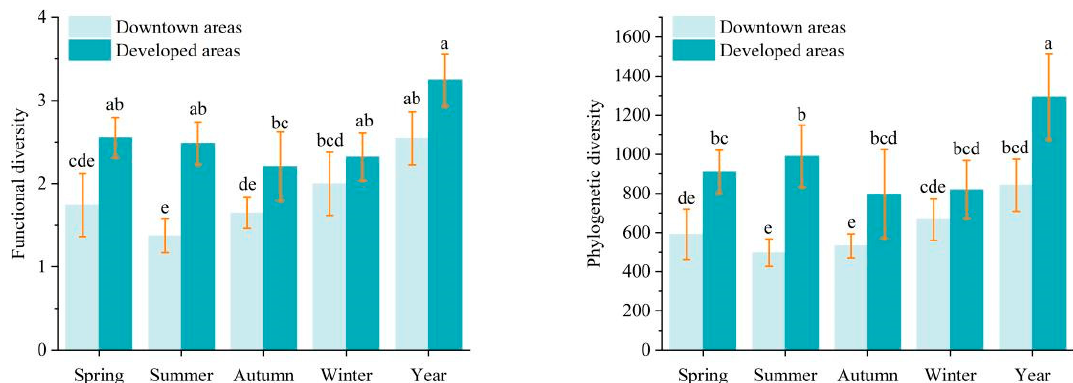
Figure 3. Comparing the annual and seasonal bird functional and phylogenetic diversity at the campuses located in the downtown and newly developed areas in Nanjing. Different letters above the bars indicate statistical significance at the 0.05 level, measured by Tukey’s post hoc